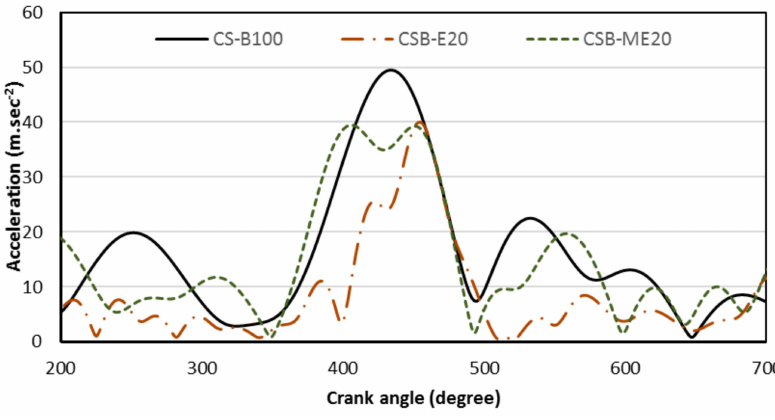
Figure 7. Heat release rate (J / ◦ CA) at an engine speed of 2900 rpm.